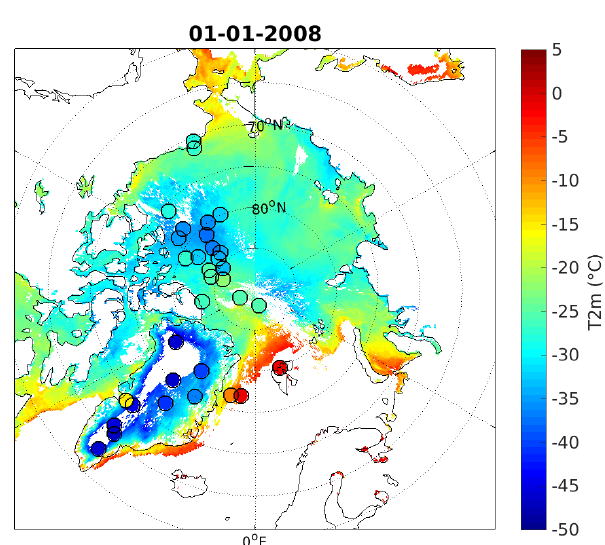
Figure 6. Daily mean 2m air temperature over land ice and sea ice from 1 January 2008. Circles show in situ